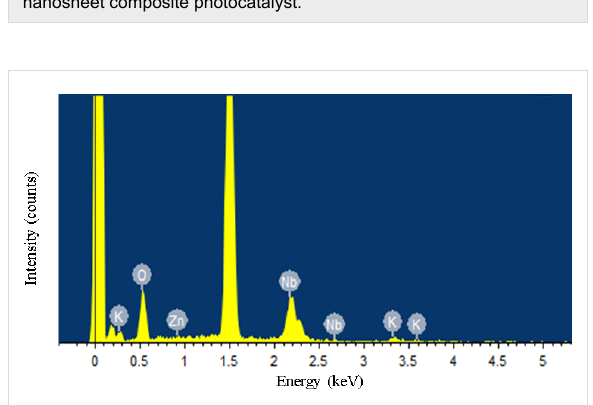
Figure 5: HRTEM image of the 2 wt % ZnO quantum dot/KNb 3 O 8 nanosheet composite photocatalyst.